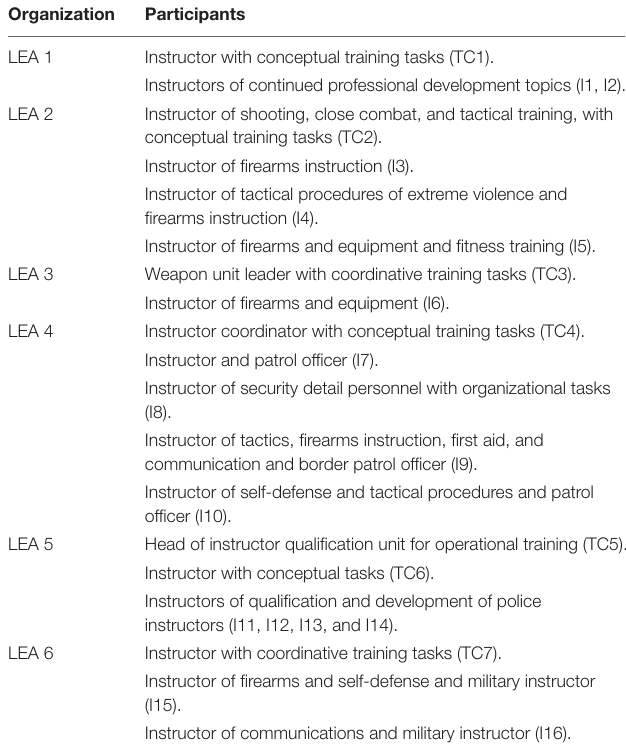
TABLE 1 | Profiles of the participants per law enforcement